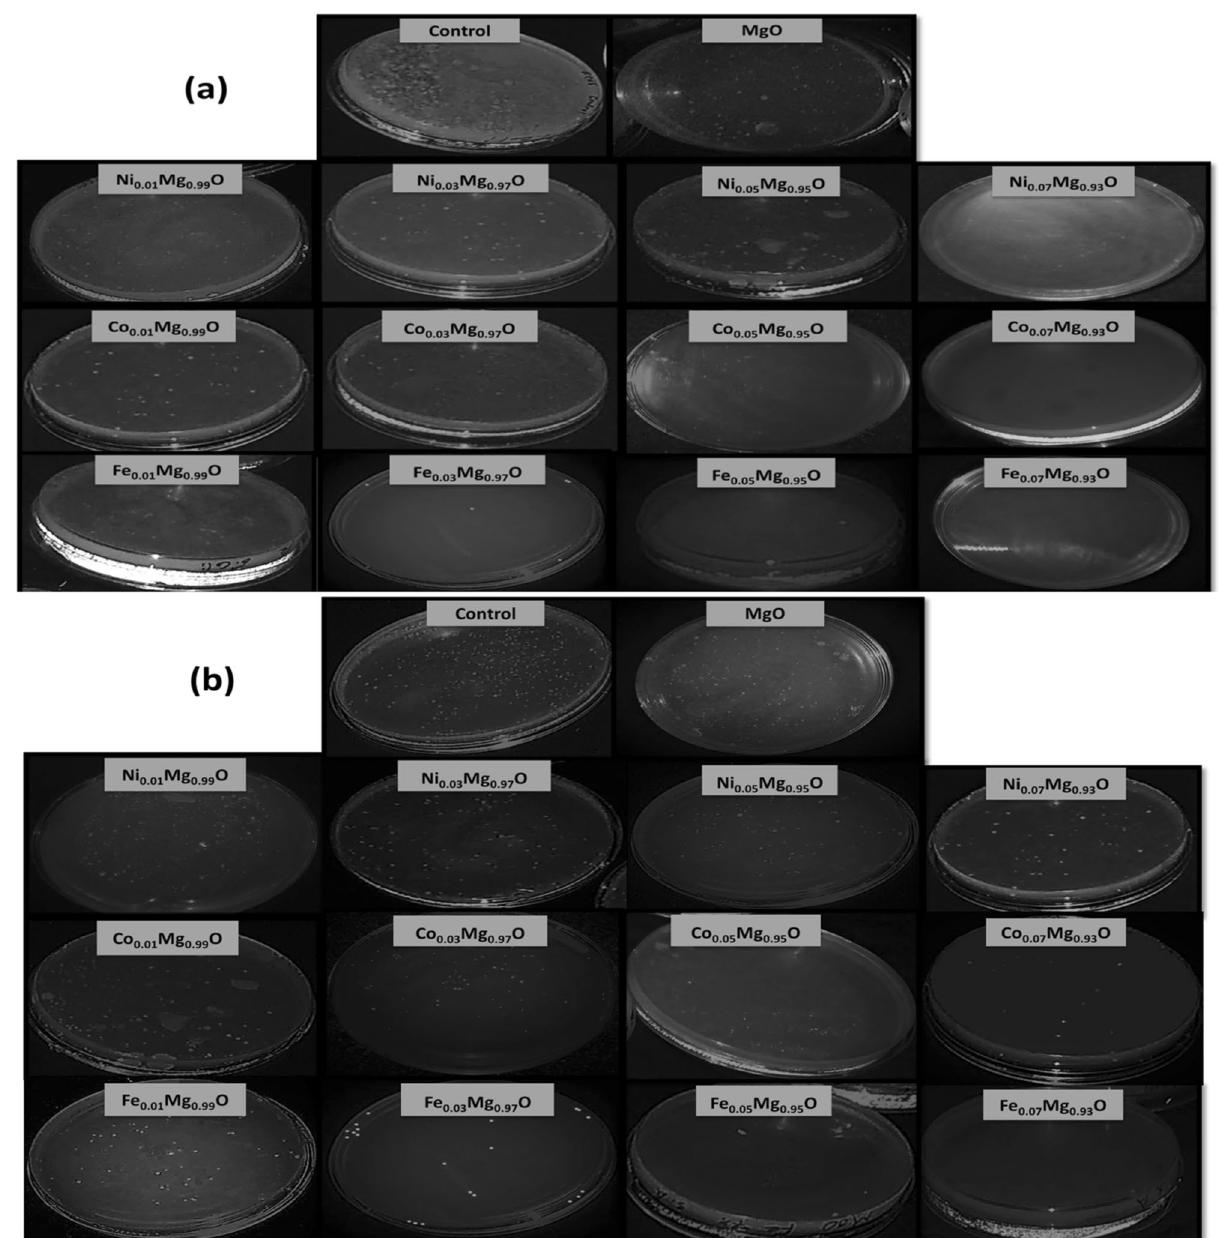
Figure 19. Representative photographs of recultivated bacteria colonies of ( a ) E. coli and ( b ) S. aureus on nutrient agar culture plates treated with 80 μg/ml of different